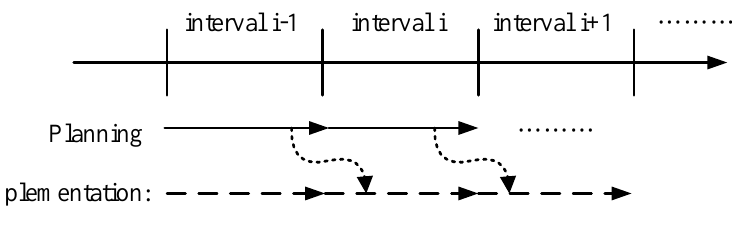
Figure 2. Operation procedure for islanded microgrid